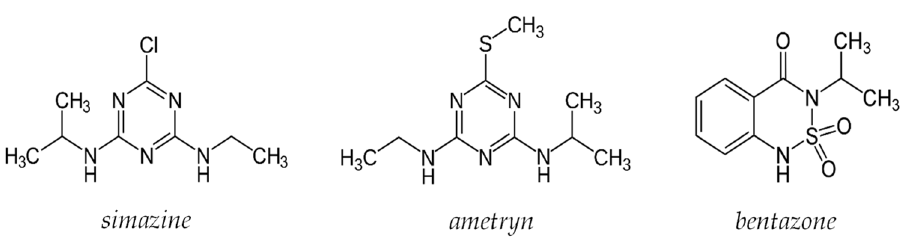
Figure 9. Structure of the pesticide used for interferent’s test.